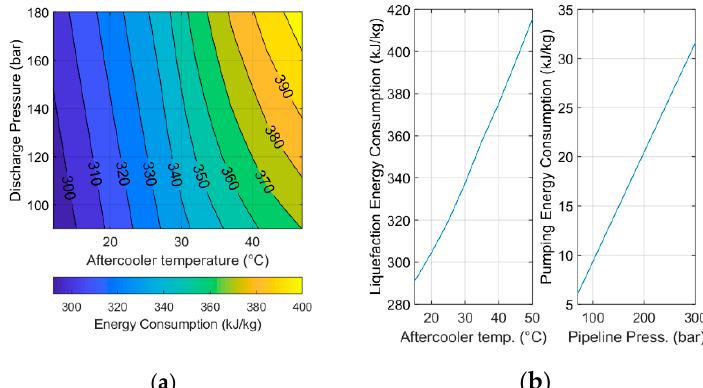
Figure 4. Modeling Basis for the Energy Consumption for Compression, ( a ) Liquefaction and Pumping Power ( b ).